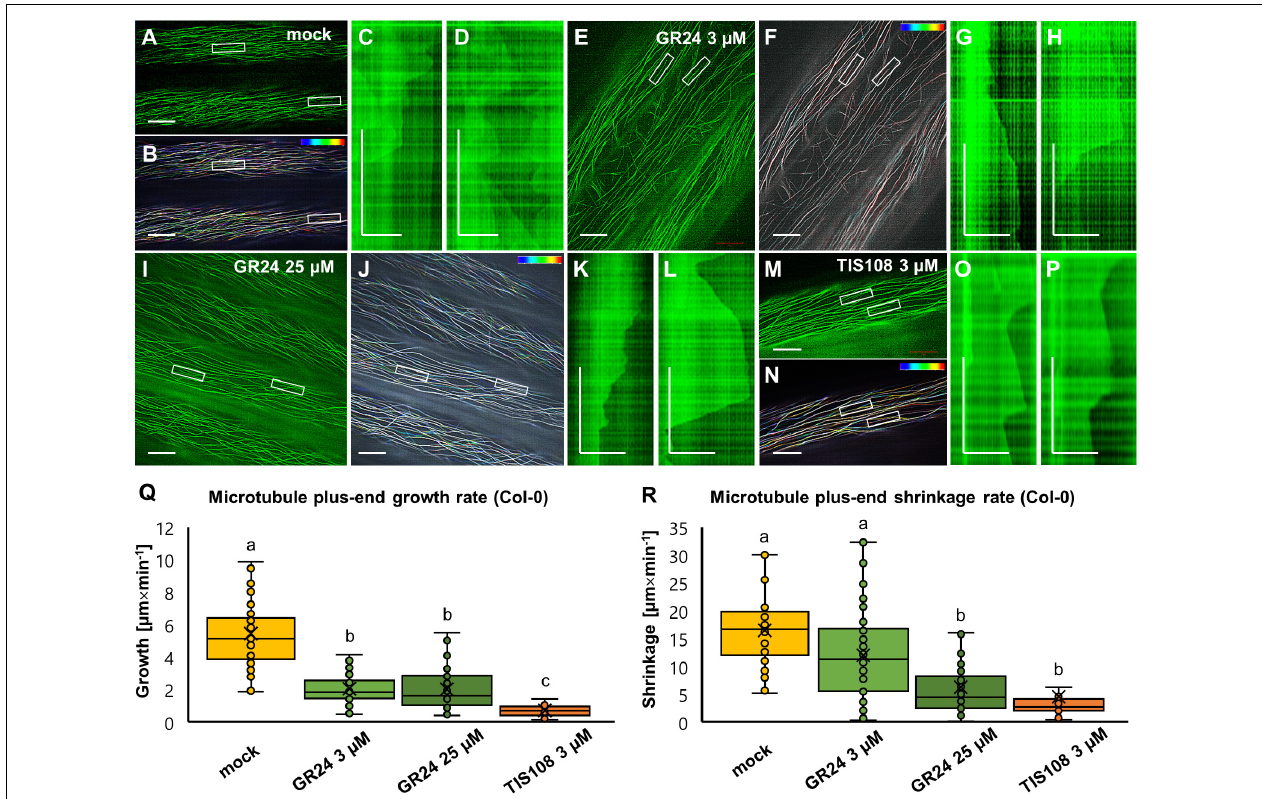
FIGURE 7 | Analysis of microtubule dynamics of Arabidopsis Col-0 expressing the GFP-MBD microtubule marker in the presence or absence of the synthetic strigolactone GR24 (3 µ M and 25 µ M) or the biosynthetic inhibitor of strigolactone production TIS108 (3 µ M). (A,B) Overview (A) and color-coded projection (B) of the time series corresponding to mock-treated Col-0 (see Supplementary Movie 1 ). (C,D) Two kymographs showing length fluctuations of the left (C) and the right (D) boxed areas of panel (A,B) . (E,F) Overview (E) and color-coded projection (F) of the time series corresponding to Col-0 treated with 3 µ M GR24 ( Supplementary Movie 2 ). (G,H) Two representative kymographs from boxed areas 1 and 2 of panels (E,F) showing decelerated and sustainable growth and shrinkage. (I,J) Overview (I) and color-coded projection (J) of the time series corresponding to Col-0 treated with 25 µ M GR24 ( Supplementary Movie 3 ). (K,L) Two representative kymographs from boxed areas 1 and 2 of panels (I,J) showing prolonged growth and shrinkage at lower rates compared to mock-treated cells. (M,N) Overview (M) and color-coded projection (N) of the time series corresponding to Col-0 treated with 3 µ M TIS108 ( Supplementary Movie 4 ). (O,P) Two representative kymographs from boxed areas 1 and 2 of panels (M,N) showing prolonged growth and shrinkage at lower rates compared to mock-treated cells. (Q,R) Quantitative assessment of microtubule growth [ (Q) ; N ≥ 33; Welch’s ANOVA was followed with Scheffé’s test; a statistical comparison is shown within groups sharing the same genotype; letters in the graph are shared by groups without statistically significant differences at the 0.01 probability level; results are in Supplementary Table 10 ] and shrinkage [ (R) ; N ≥ 28; Welch’s ANOVA was followed with Scheffé’s test; a statistical comparison is shown within groups sharing the same genotype; letters in the graph are shared by groups without statistically significant differences at the 0.01 probability level; results are in Supplementary Table 11 ] of Col-0 GFP-MBD-labeled microtubule in all experimental conditions. In all box plots, the average is presented by × , median by the middle line, 1 st quartile by the bottom line, 3 rd quartile by the top line; the whiskers lie within the 1.5 × interquartile range (defined from the 1 st to the 3 rd quartiles) while outliers are omitted. Scale bars: 10 µ m (A,B,E,F,I,J,M,N) ; 5 µ m (C,D,G,H,K,L,O,P) . All time bars correspond to 2 min.